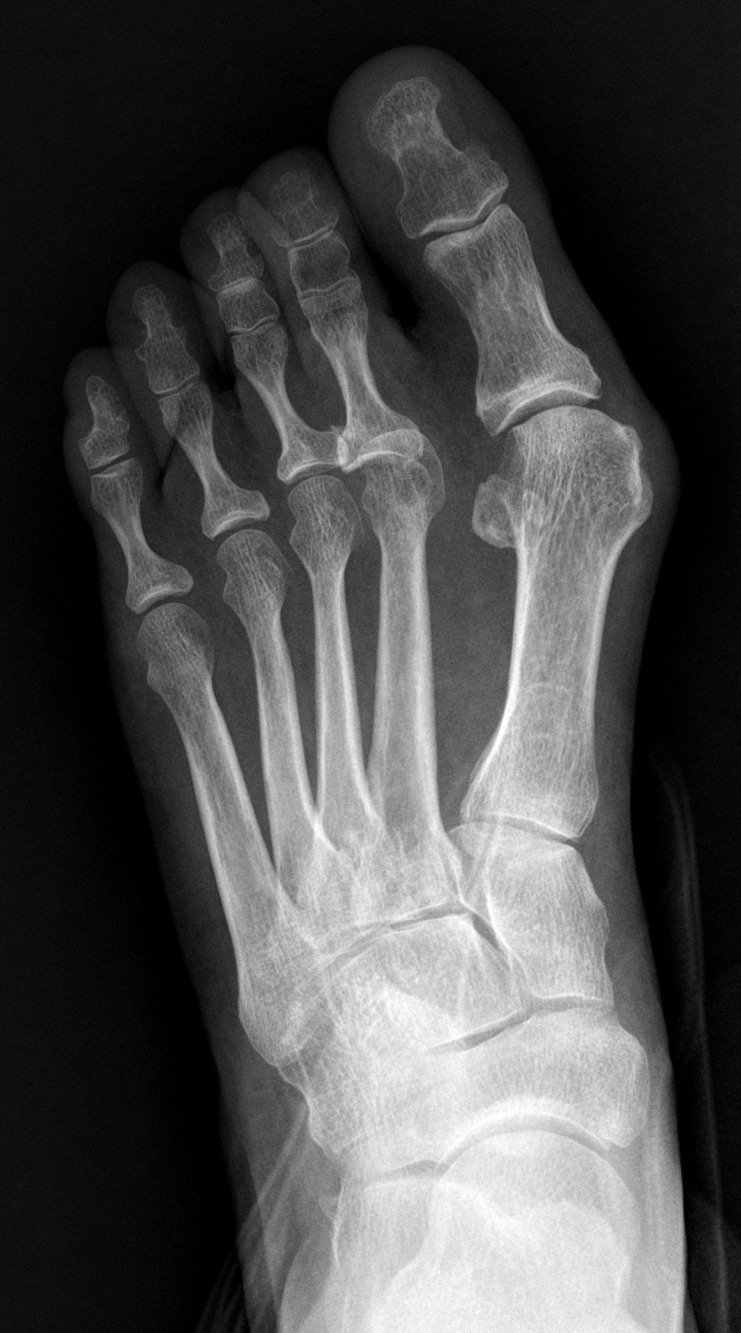
Preoperative weightbearing X-ray of a 55-year-old female.Notice the excessive length of the great toe and protrusion of the first metatarsal.